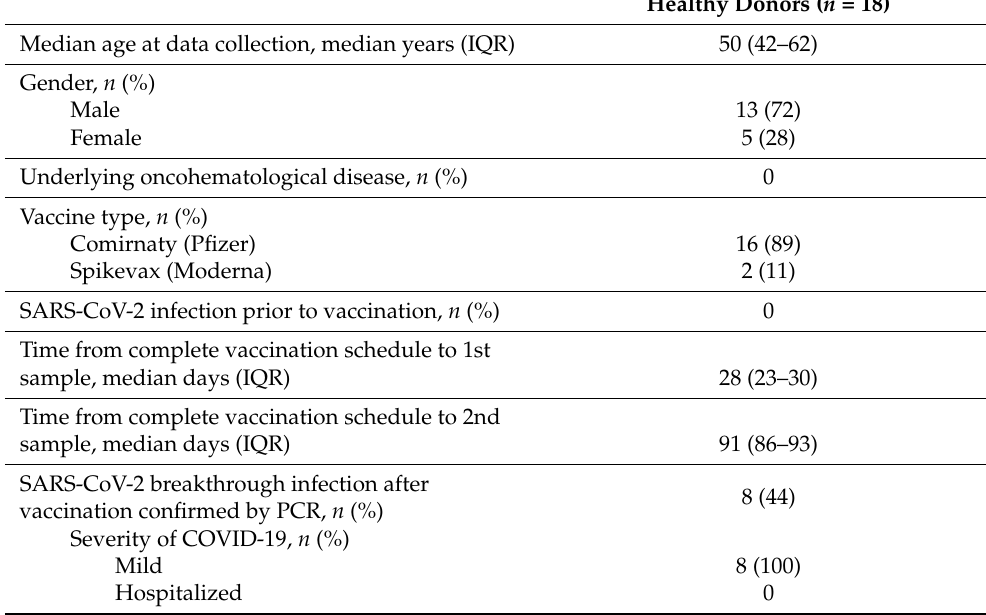
Table 2. Sociodemographic and clinical data of the healthy donors who participated in this study as